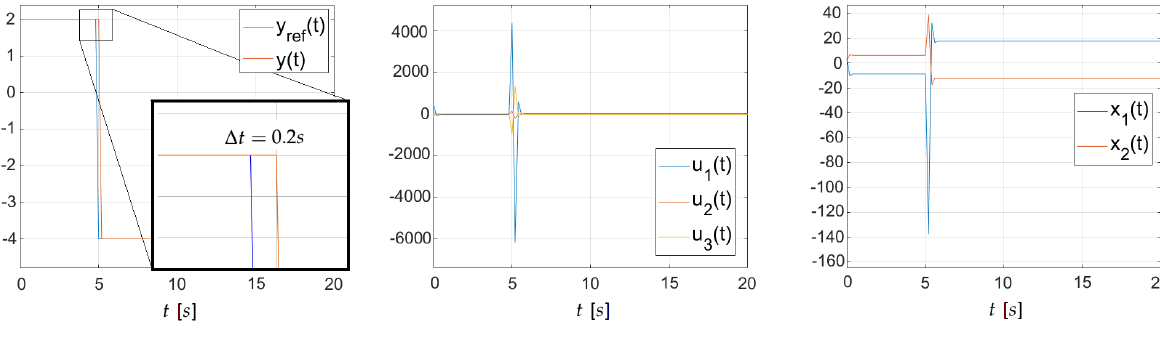
Figure 3. Perfect control plots: σ -inverse, case ∆ t = 0.2